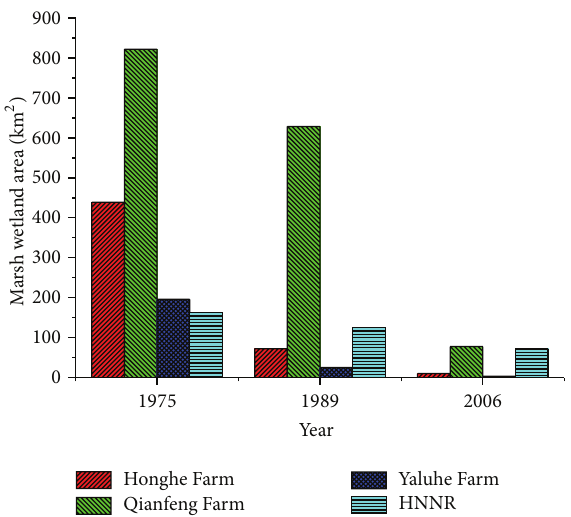
Figure 3: Loss of the marsh wetland of 4 units within the study area in the past 30